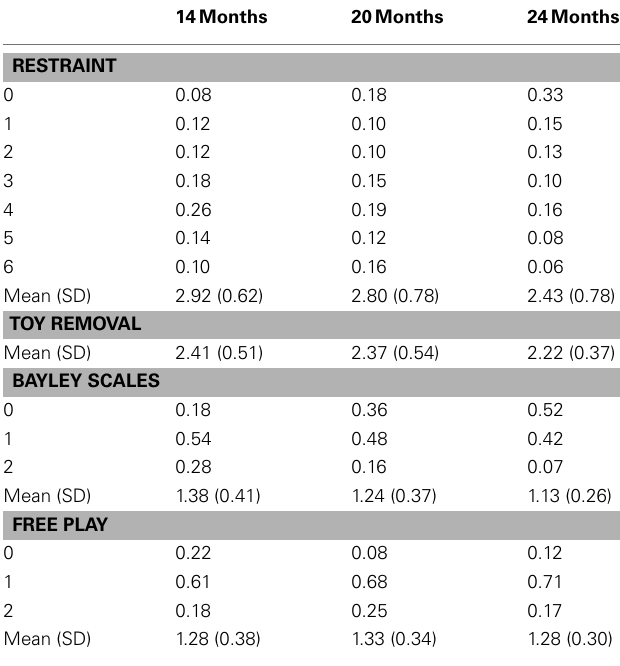
Table 2 | Proportion of individuals in each category and mean (SD) of Restraint, Bayley Scales, and Free Play and the mean (SD) ofToy Removal at each